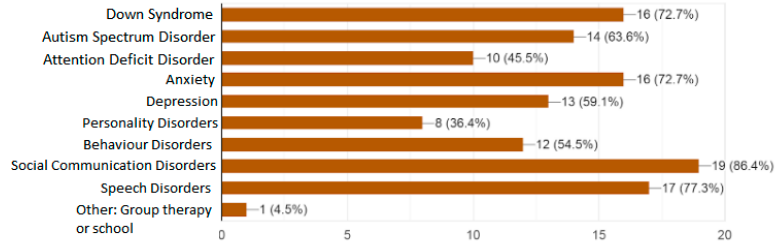
Figure 5. The question “Who would you use MAmIoTie with?”, with the answers represented in a bar graph of the different cases professionals would consider using MAmIoTie with.